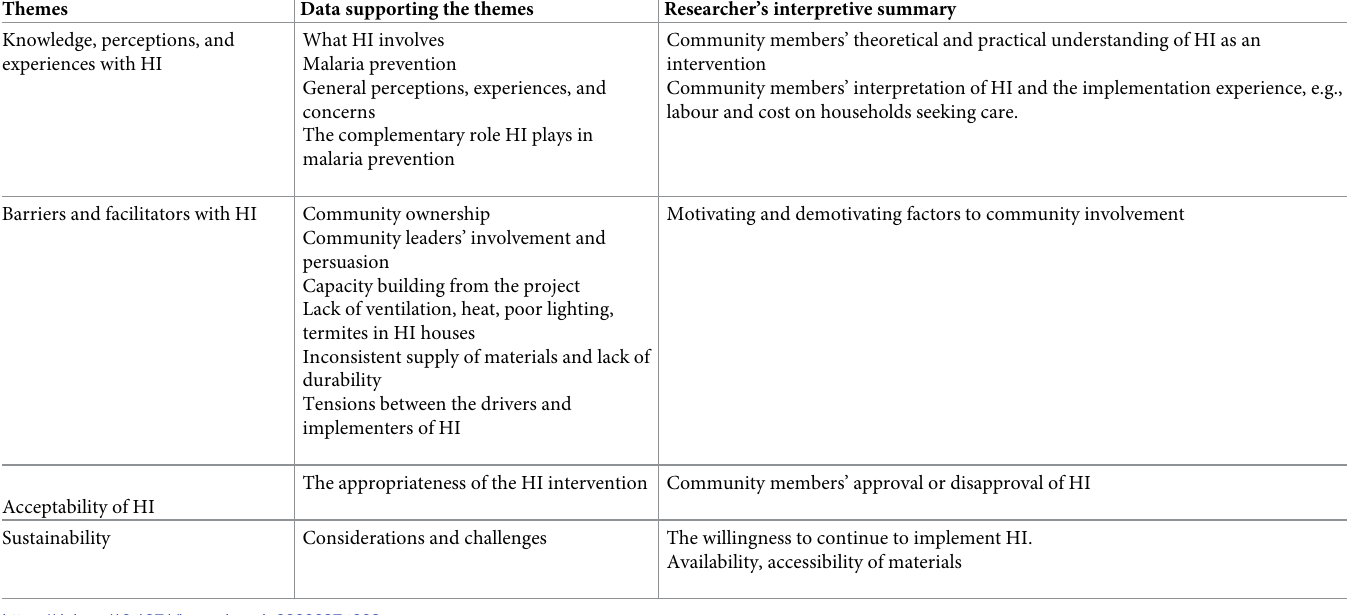
Table 2. Main themes from the qualitative